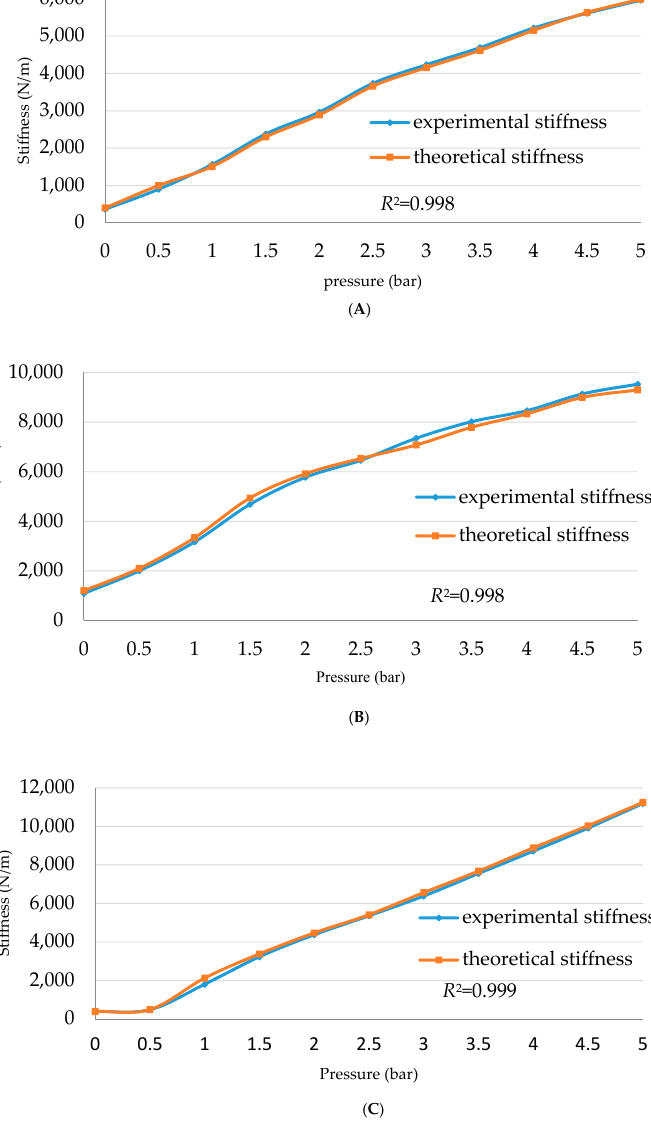
Figure 14. The experimental and theoretical stiffness of the three different PMAs. ( A – C ) represent the stiffness for the PMAs in Table 5